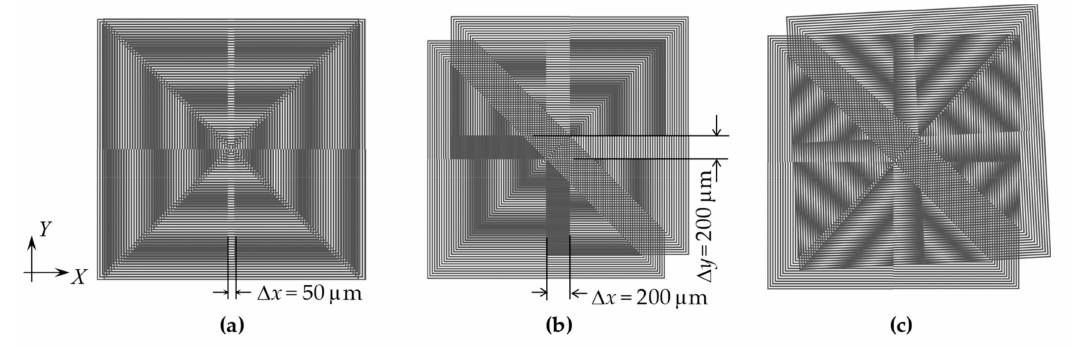
Figure 5. Moir é fringe patterns with large misalignments beyond the moir é measurement range: ( a ) ∆ x = 50 µ m, ∆ y = 0; ( b ) ∆ x = ∆ y = 200 µ m; ( c ) ∆ x = ∆ y = 200 µ m with an angular error ( δ = 3 ◦ ).